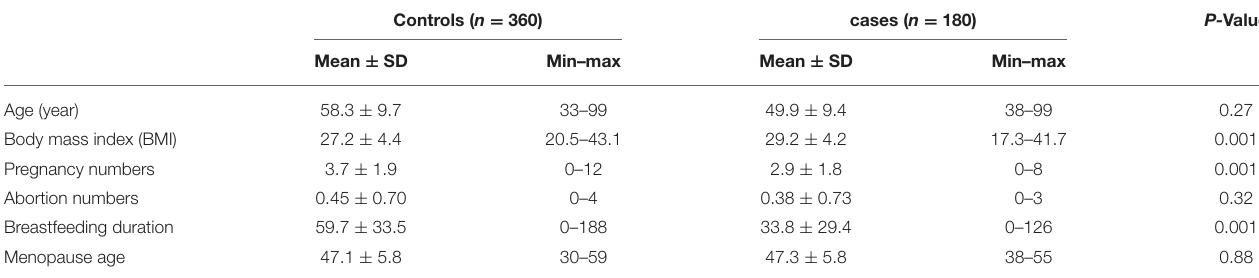
TABLE 1 | Distribution of characteristics across cases and controls ( n = 540).